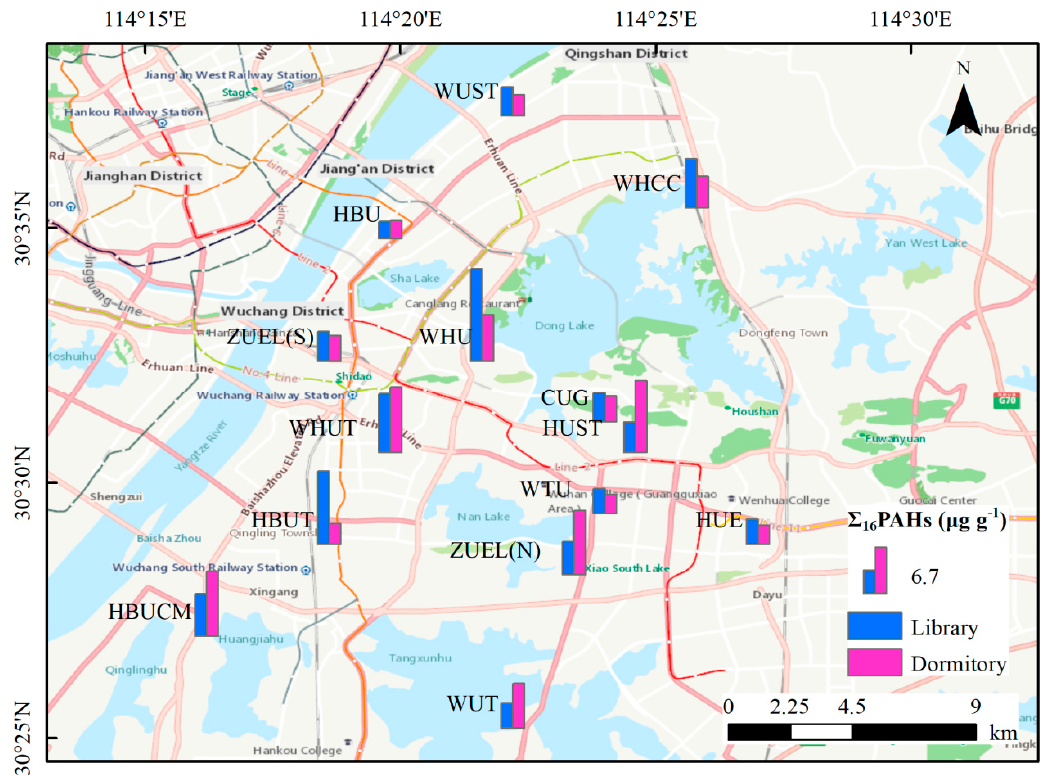
Figure 1. Sampling sites for the atmospheric dustfall samples in Wuhan, China.